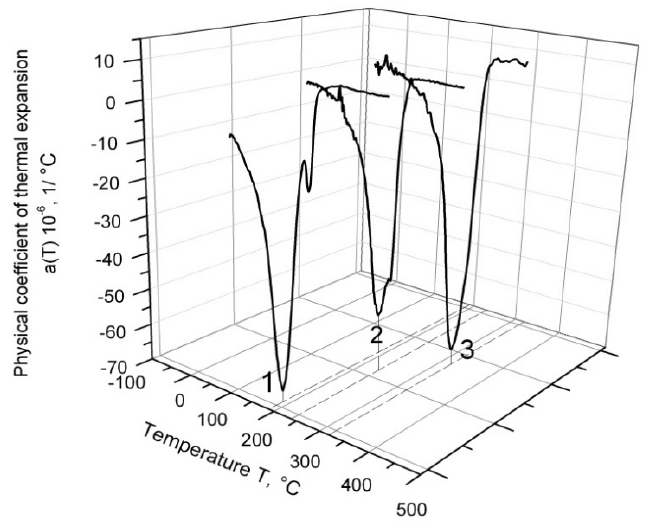
Figure 2. Temperature dependence of thermal expansion coefficient for ChS-139 (1), EP-823 (2), and EK-181 steels (3).